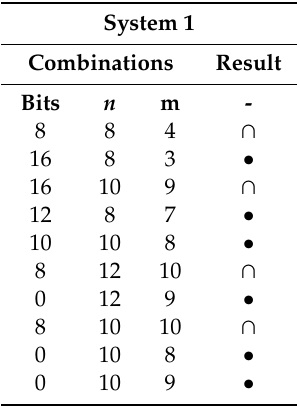
Table 5. Results of multifractal analysis of system 2.